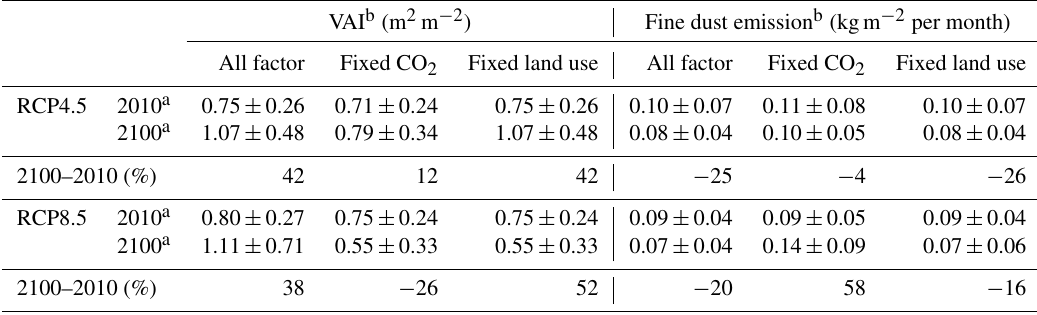
Table 1. The averaged spring vegetation area index (VAI) and fine dust emission in southwestern North America for the present day and future for two scenarios (RCP4.5 and RCP8.5) and three cases. The all-factor case includes changes in climate, land use, and CO 2 fertilization; the fixed-CO 2 case includes changes in only climate and land use; and the fixed-land-use case includes changes in only climate and CO 2 . The rows labeled “2100–2010 (%)” give the percentage changes in the VAI and fine dust emissions between the present day and future, with positive values denoting increases in the